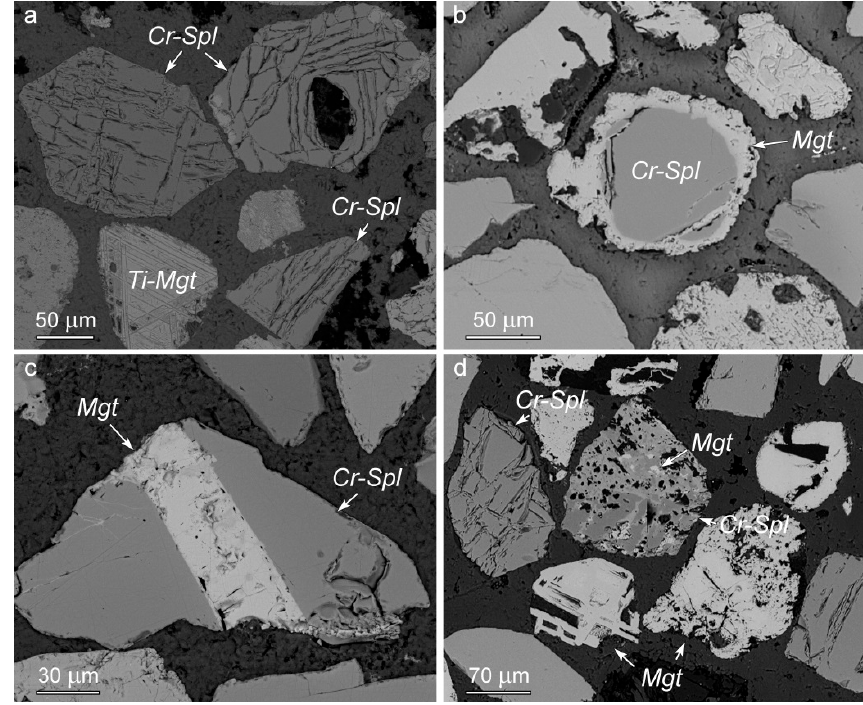
Figure 7. BSE images of chromspinels in a polished section of chromitolites from Sabantuy paleoplacer: ( a ) fractured grains, ( b ) grain with secondary magnetite rim, ( c ) grain with magnetite band and ( d ) patchy and spongy structure grain. Note: Cr-Spl—chromspinel, Mgt—magnetite and Ti-Mgt—titanomagnetite.